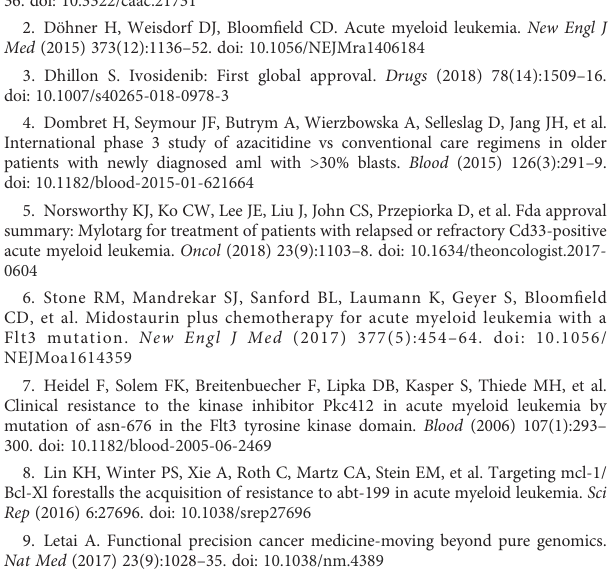
SUPPLEMENTARY FIGURE 8 ssGSEA analysis for high- and low-risk groups. (A) Immune cell in fi ltration in high- and low-risk groups as determined by ssGSEA analysis. (B, C) . Correlations between each immunocyte in fi ltration level in low- (B) and high-risk group (C) . (D, E) . Heatmap displaying the correlations between hub genes and immunocyte in fi ltration level in low- (D) and high-risk group (E) . *P-value< 0.05, **P-value< 0.01, ***P-value< 0.001, ns, no signi fi cance.